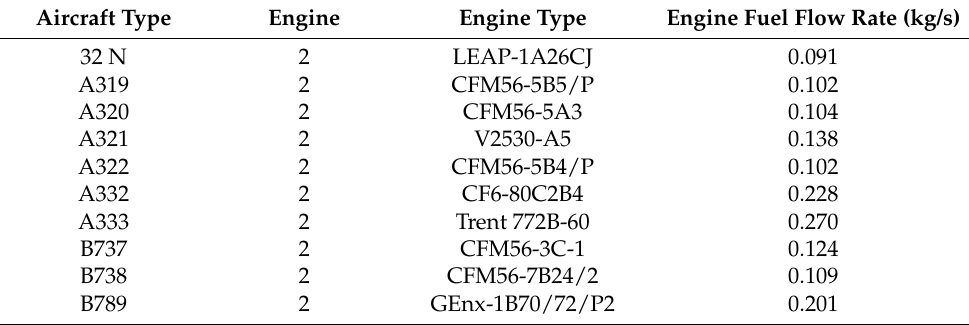
Table 3. Engine fuel flow rates under idle conditions.